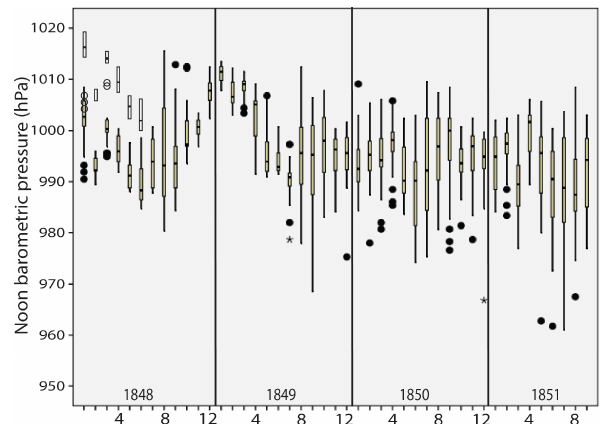
Figure 11. Pressure series for the second half of the Reverend Richard Davis meteorological record showing adjusted and unad- justed (clear/white boxes) pressure series for January–June 1848. Circles represent values that are 1.5 to 3 times the interquartile range away from the middle 50% of all of the data, while stars represent extremes that are more than 3 times the interquartile range